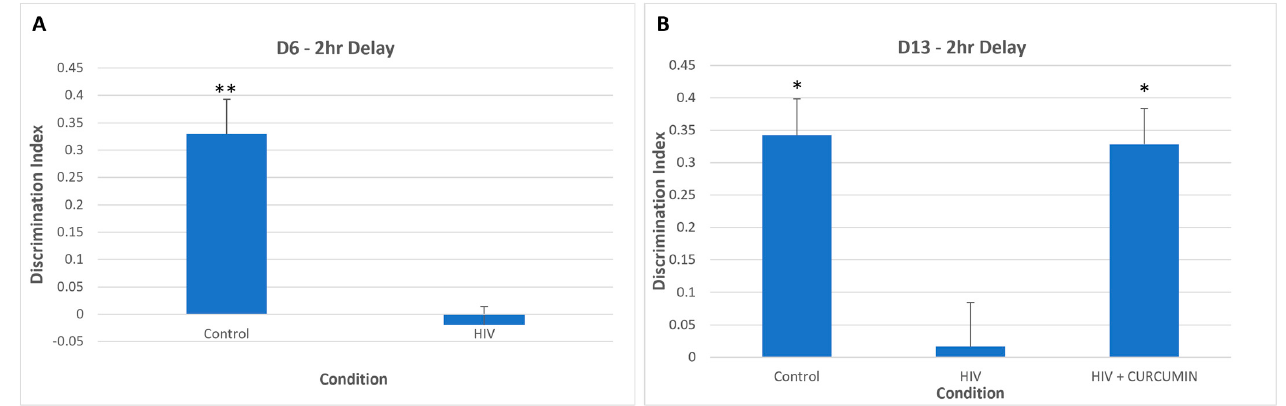
Figure 2. Object recognition testing of Control, HAND (HIV) saline treated, and HAND (HIV) curcumin treated (50 mg/kg) mice. Day 6 with 2 h delay, before introduction of the novel object, in Control and HAND mice ( A ). Day 13 with 2 h delay in Control, HAND and HAND treated with curcumin ( B ). * p =0.00015,** p = 0.000003.